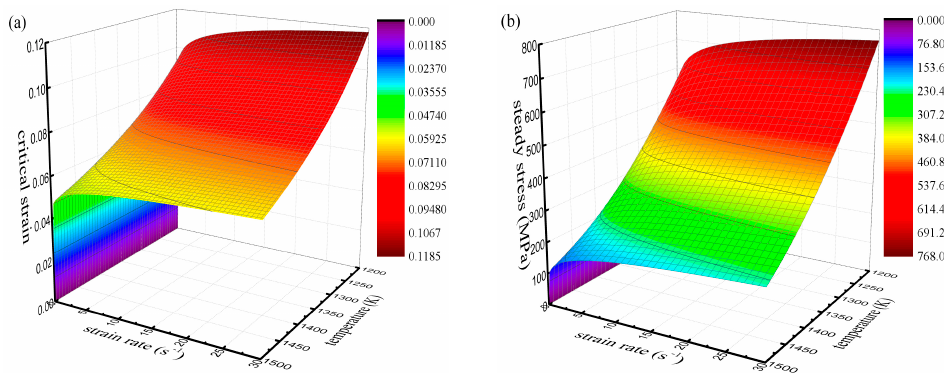
Figure 17. The influence of temperature and strain rate on ( a ) the critical strain model and ( b ) the steady stress. Metals 2016 , 6 , 161 16 of 19